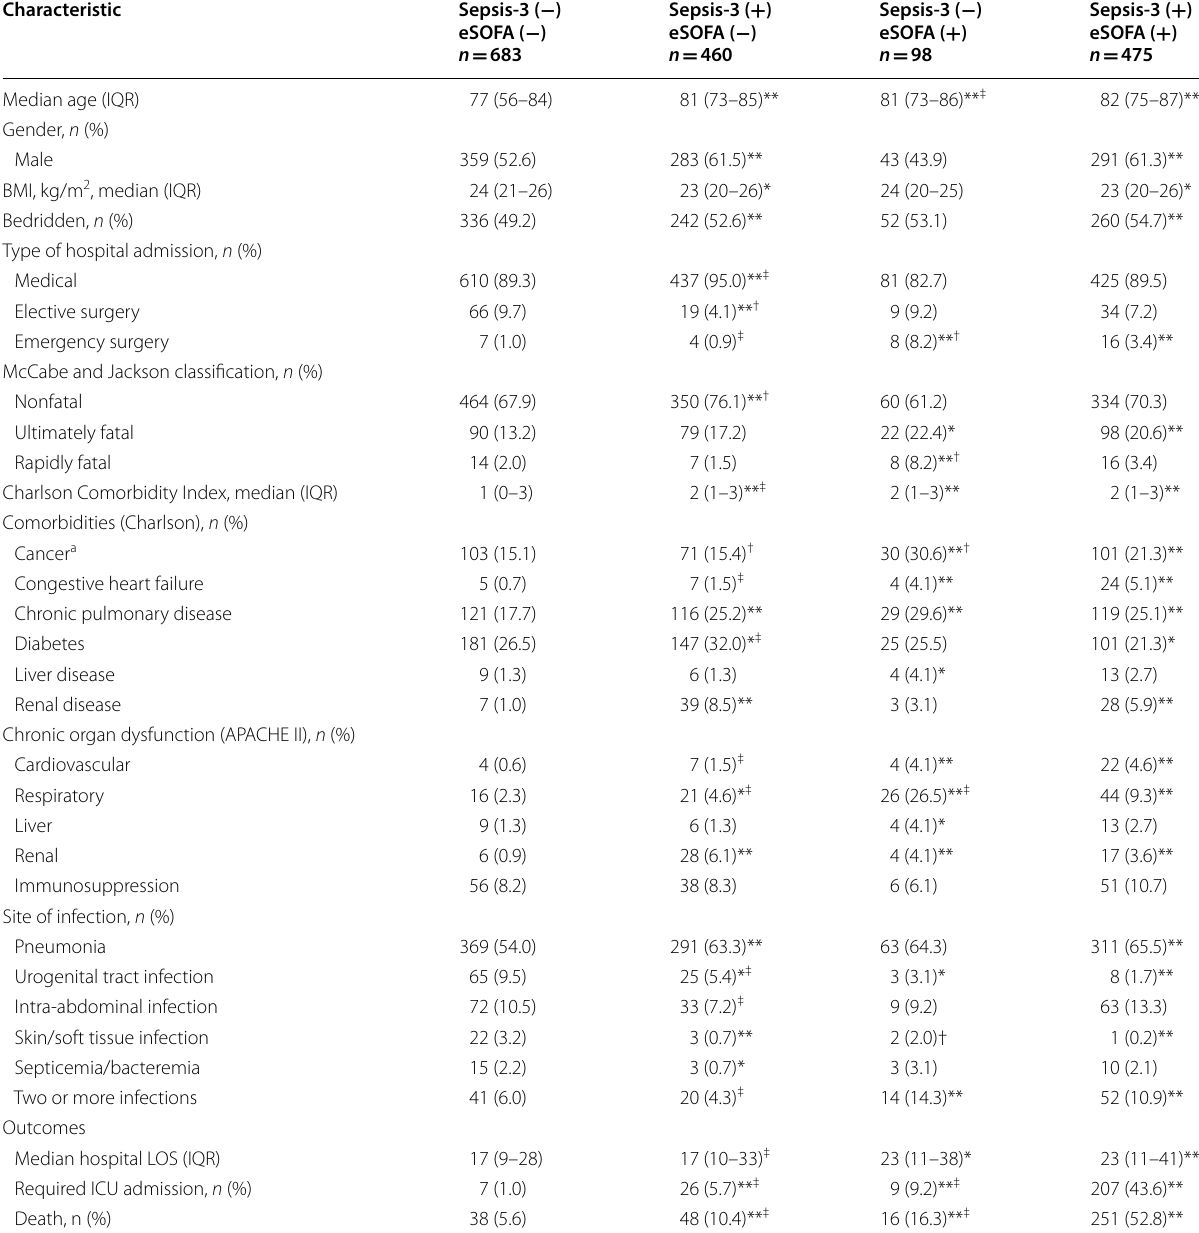
Table 2 Characteristics of sepsis patients categorized by overlap of Sepsis-3 and eSOFA criteria (Adult Sepsis